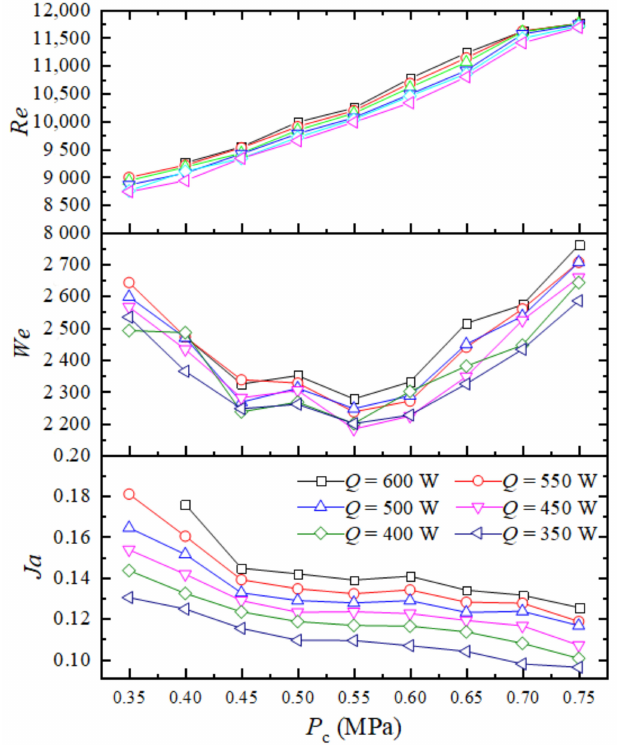
Figure 9. Curves of dimensionless numbers with a refrigerant charge at each heating